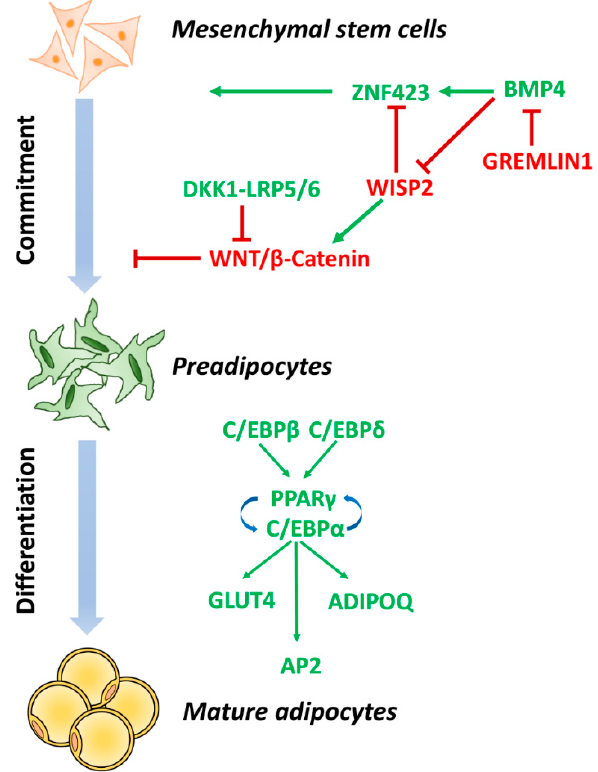
Figure 2. Molecular mechanisms of adipogenesis. Adipogenesis can be divided into two phases: commitment and terminal differentiation. Bone morphogenetic protein 4 (BMP4) induces mesenchymal progenitor cells to the adipocyte lineage as part of the adipogenic commitment. As a result of BMP4 signaling pathways, committed preadipocytes express the transcriptional activator zinc-finger protein 423 ( ZNF423 ), a fundamental determinant of preadipocyte cell fate. The commitment phase also requires coordinated inhibition of several pathways [e.g., wingless-type mouse mammary tumor virus integration site family (WNT) and wnt1-inducible-signalling pathway protein 2 (WISP2)]. During terminal differentiation phase, committed preadipocytes arrest their growth and activate early differentiation markers, including peroxisome proliferator-activated receptor- γ ( PPAR γ ) and transcription co-activators CCAAT/enhancer-binding protein α ( C/EBP α ). C/EBP α and PPAR γ induce and maintain the expression of key adipogenic genes ( GLUT4, AP2, and ADIPOQ ), which are necessary for normal adipocyte function. WISP2, WNT1-inducible signaling pathway protein 2; DKK1, proadipogenic factors Dickkopf 1. LRP5/6, lipoprotein-receptor-related protein-5 or -6; GLUT4, glucose transporter type 4; AP2, adipocyte fatty acid-binding protein 2.